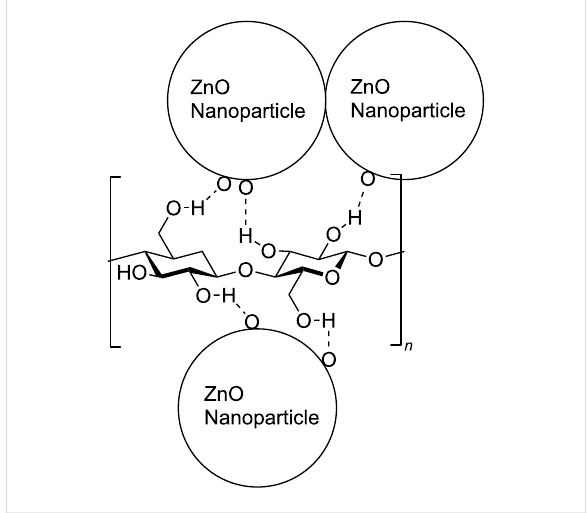
Figure 5: Schematic diagram showing possible hydrogen bonding of the hydroxy groups on the cellulose molecule with surface oxygen atoms of the ZnO